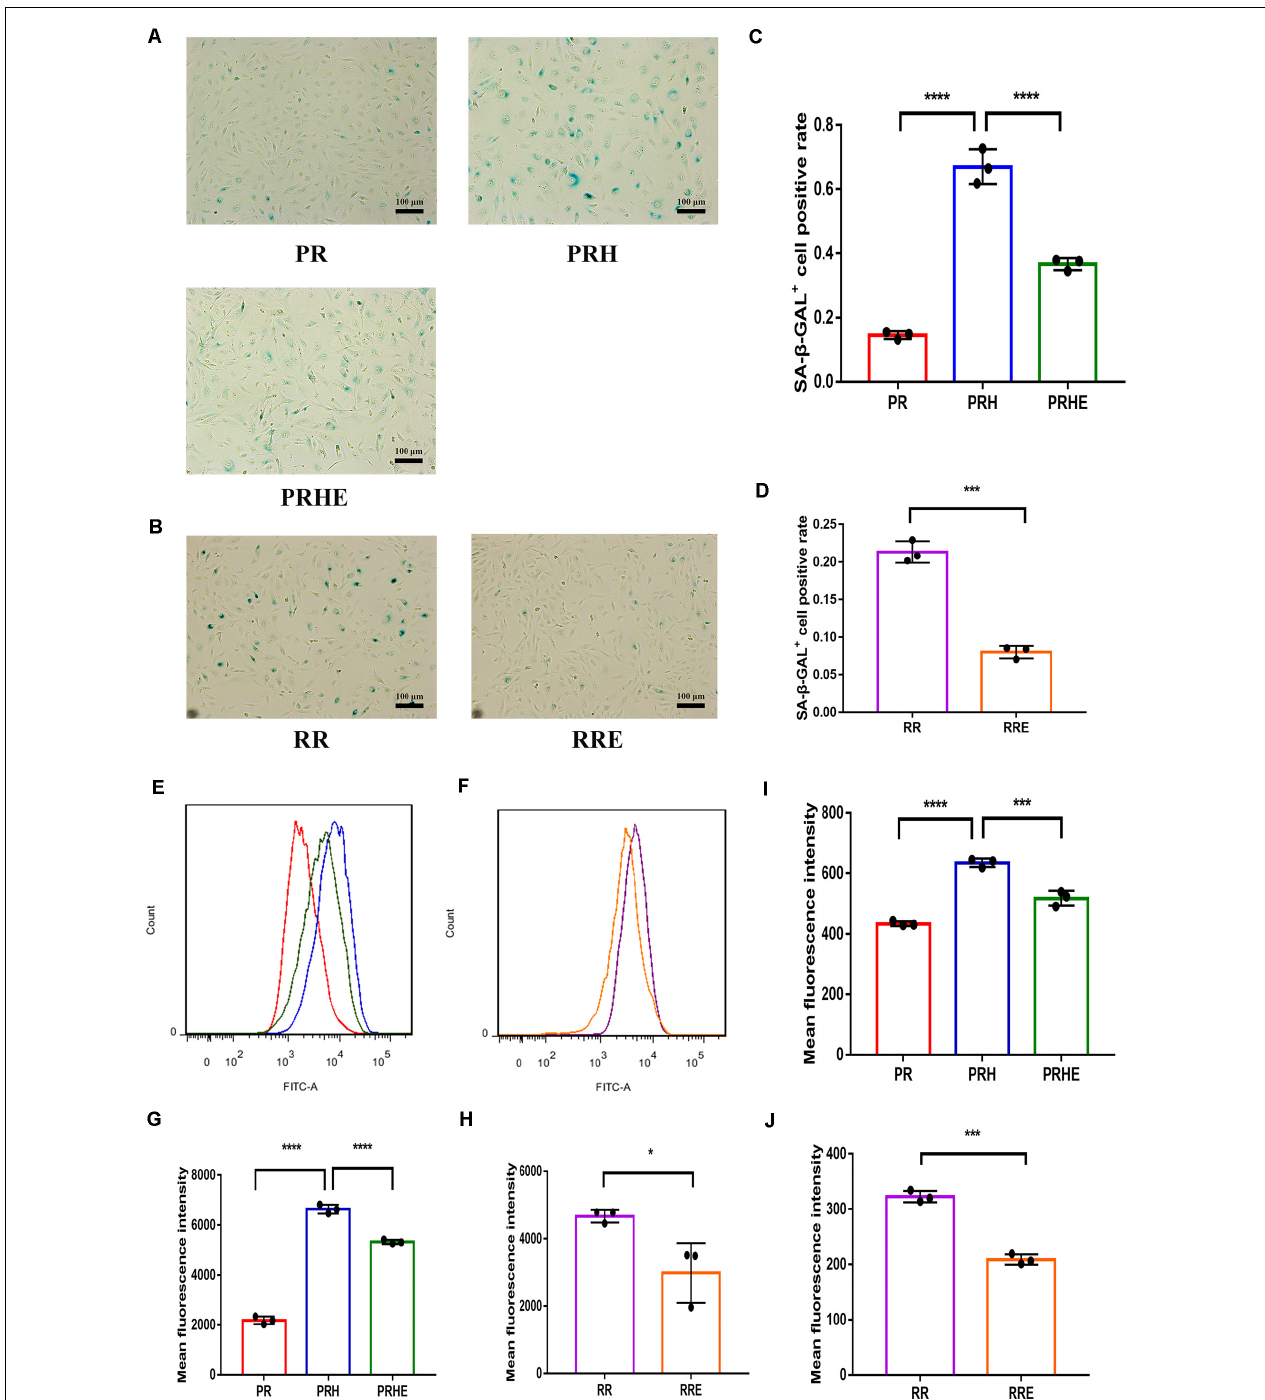
FIGURE 5 | The cocultured ESCs reduced the senescent phenotypes of premature and replicative senescent RPE cells. (A) SA- β -GAL activity in the PR, PRH, and PRHE groups, as indicated by phase contrast microscopy. Scale bar, 100 µ m. (B) SA- β -GAL activity in the RR and RRE groups, as indicated by phase contrast microscopy. Scale bar, 100 µ m. (C,D) Results from the quantification of SA- β -GAL + cells shown in (A,B) , respectively ( n = 3 biological repeats). SA- β -GAL + cells in 4 random fields were scored. The results are expressed as the percentage of stained cells. (E) Reactive oxygen species (ROS) levels in the PR, PRH, and PRHE groups, as assessed by flow cytometry ( n = 3 biological repeats). (F) ROS levels in the RR and RRE groups, as assessed by flow cytometry ( n = 3 biological repeats). (G,H) Results from the mean fluorescence intensity shown in (E,F) , respectively. (I) Mitochondrial membrane potential (MMP) levels in the PR, PRH, and PRHE groups, as assessed by a microplate reader ( n = 3 biological repeats). (J) MMP levels in the RR and RRE groups, as assessed by a microplate reader ( n = 3 biological repeats). Data are presented as the mean ± SD. ∗ P < 0.05; ∗∗∗ P < 0.001; ∗∗∗∗ P < 0.0001.